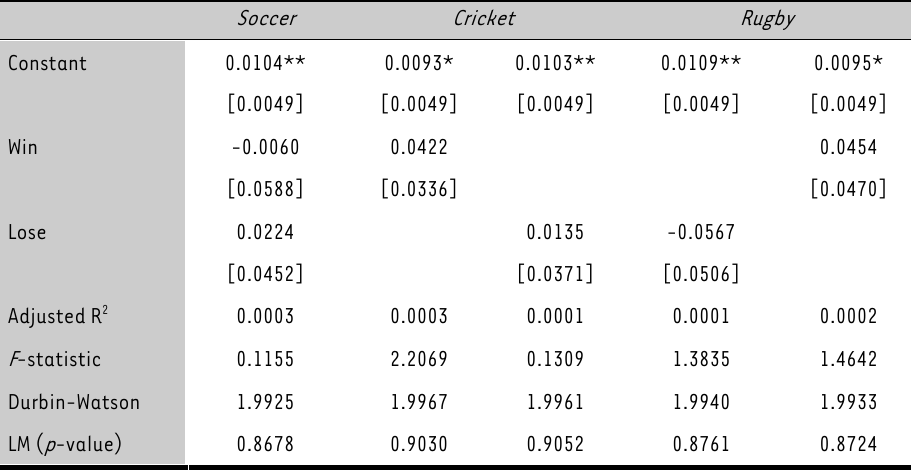
TABLE 3: OLS regression results